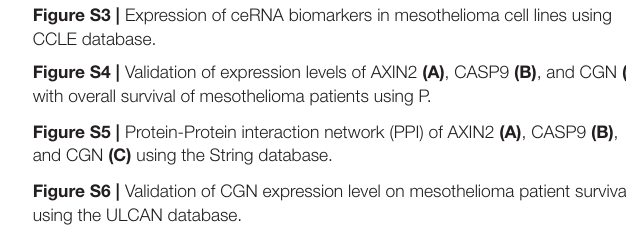
Figure S1 | Validation of AXIN2 (A,B) and CASP9 (C,D) on a transcriptional level in multiple cancer types and multiple studies using the Oncomine database. Figure S2 | Integrative analysis of genomics using the cBioPortal suggested. Figure S3 | Expression of ceRNA biomarkers in mesothelioma cell lines using CCLE database. Figure S4 | Validation of expression levels of AXIN2 (A) , CASP9 (B) , and CGN (C) with overall survival of mesothelioma patients using P. Figure S5 | Protein-Protein interaction network (PPI) of AXIN2 (A) , CASP9 (B) , and CGN (C) using the String database. Figure S6 | Validation of CGN expression level on mesothelioma patient survival using the ULCAN database. Table S1 | Baseline information of 87 patients diagnosed with mesothelioma, available from the TCGA. SD, Standard